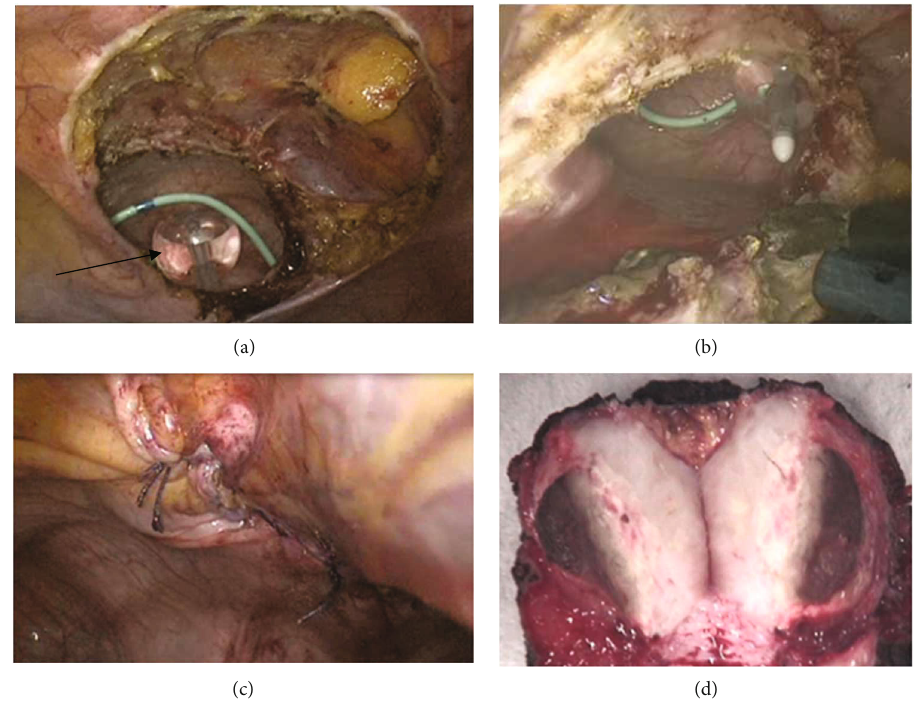
Figure 3: Intraoperative view of the bladder defect post partial cystectomy, arrow on foley catheter (a and b), view of the bladder post defect repair (c), and a cross-section of the tumor revealing a white soft myxoid mass